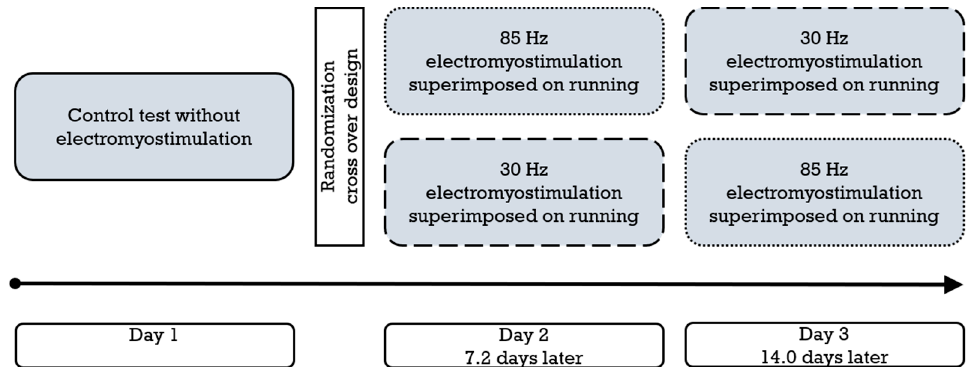
Figure 1. Schematic representation of the study design and procedure ( n = 22). The dotted frame represents 85 Hz electromyostimulation, and the dashed frame represents 30 Hz electromyostimu- lation.